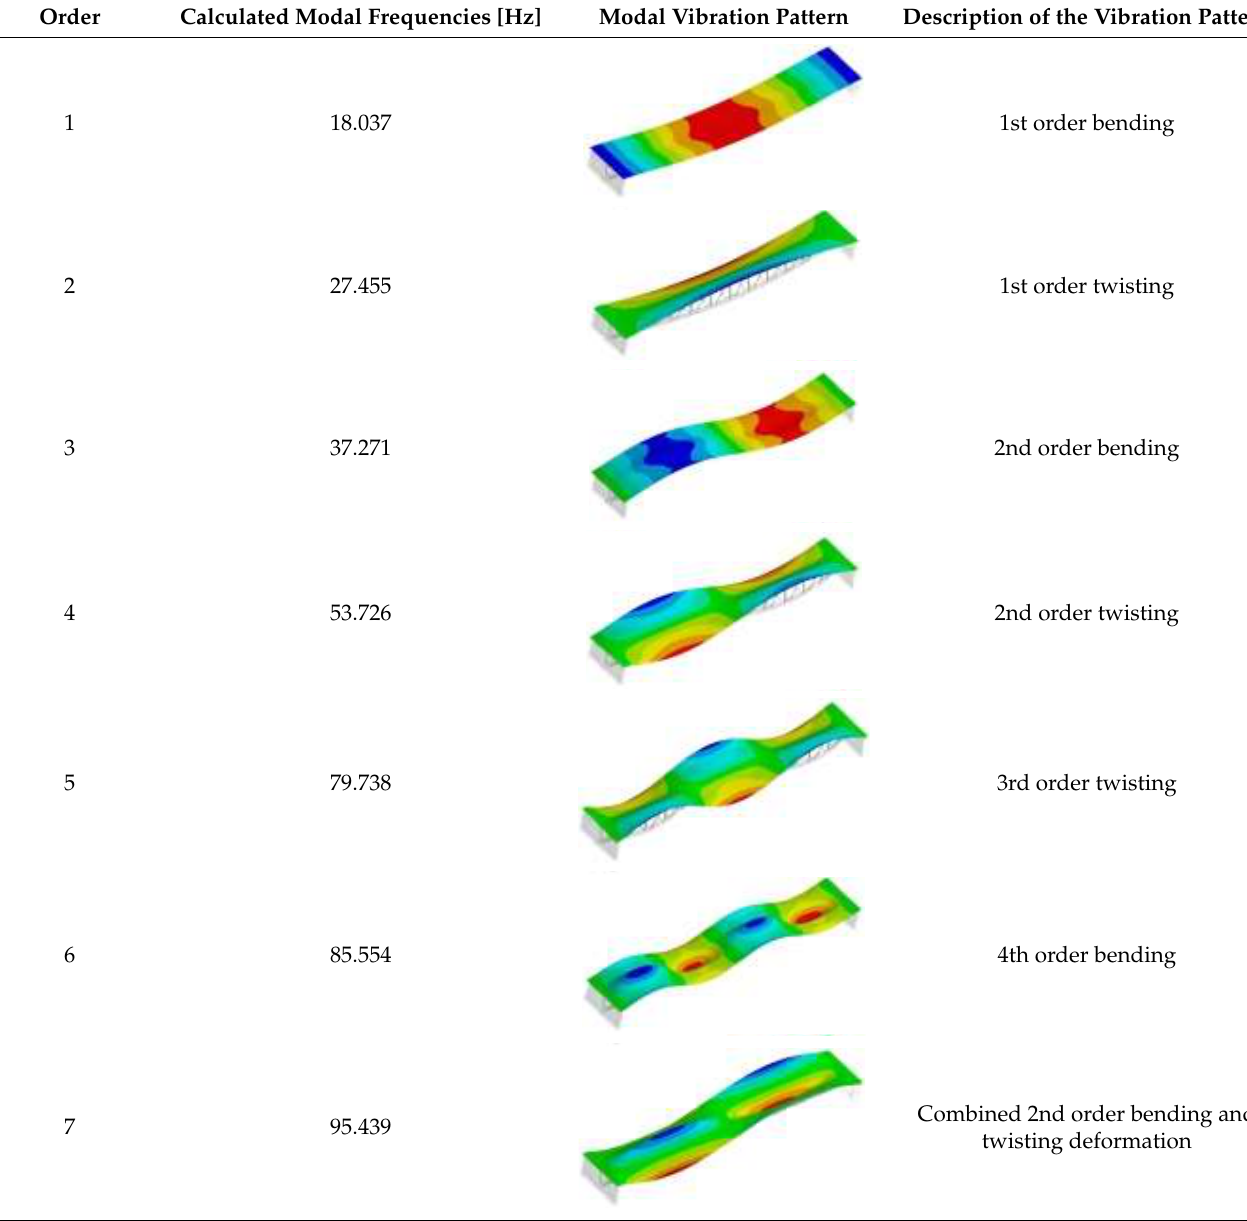
Table 3. The calculated modal frequencies and vibration patterns of the STTGB deck.